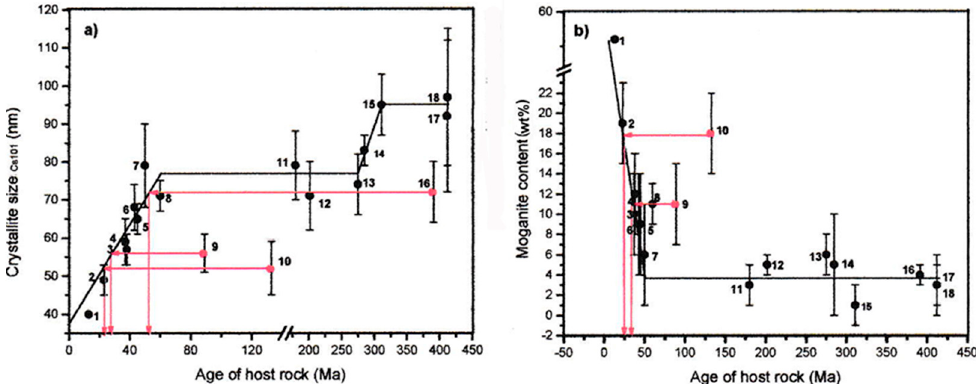
Figure 7. ( a ) Mean crystallite size as a function of age. The plot divides into four age regions: (A) an initial linear growth found in agates from host rocks aged up to 60 Ma: (B) over the next 210 Ma there is minimal growth: (C) growth restarts for 30 Ma: (D) after 300 Ma there is a final cessation of growth up to 1100 Ma. ( b ) Mean moganite content as a function of age. Agates formed from host rocks < 60 Ma show a linear decline in the moganite content and little change in the older hosts. The apparent outliers (shown in red) suggest agate formation long after the host age. Agate regions: (1) Yucca Mt., USA; (2) Mt. Warning, Australia; (3) Chihuahua, Mexico; (4) Cottonwood Springs, USA; (5) Washington, USA; (6) Las Choyas, Mexico; (7) Khur, Iran; (8) BTVP, Scotland; (9) Mt Somers, New Zealand; (10) Rio Grande do Sul, Brazil; (11) Semolale, Botswana; (12) Nova Scotia, Canada; (13) Agate Creek, Australia; (14) Thuringia, Germany; (15) Derbyshire, England; (16) East Midland Valley, Scotland; and (17) West Midland Valley, Scotland. A further 8 regions from host rocks aged between 430 and 3750 Ma are not shown as minimal change occurs after 400 Ma. Error bars show one standard deviation. XRD details: Grain size < 10 µ m using a Brucker D8 di ff ractometer in the reflection mode, crystallite size was based on the main (101) quartz reflection recorded on scans 17 ◦ < 2 θ < 30 ◦ with step size of 0.01 ◦ 2 θ and a scan speed of 10 s / step. The changed details for the moganite determination were 17 ◦ < 2 θ < 25 ◦ , step size of 0.02 ◦ 2 θ and a scan speed of 20 s / step. The moganite and quartz peak areas were determined by fitting unconstrained Lorentzian functions using the Advanced Fitting Tool in “Origin” Moganite content has been taken as the proportion (in %) of moganite peak area / total area with an estimated resolution of ± 2%. Full data is given in Moxon and Carpenter [50].